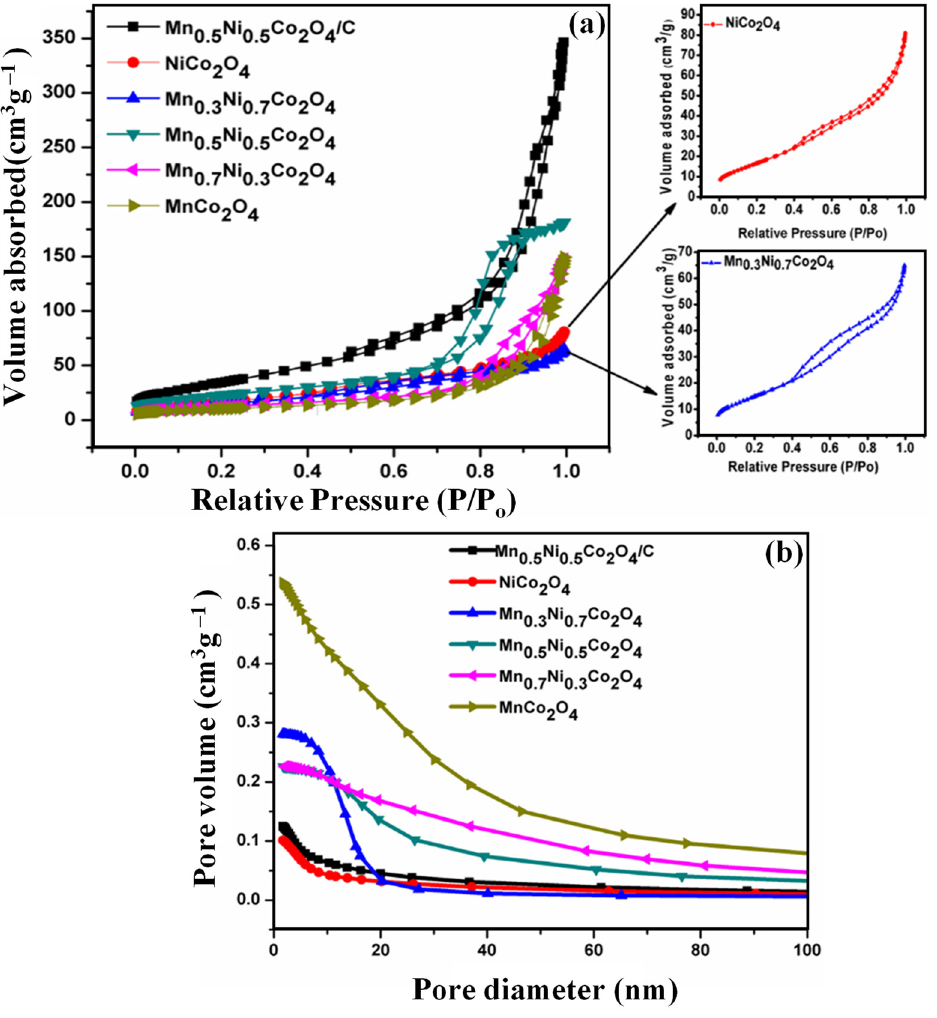
Figure 6. ( a ) Nitrogen adsorption/desorption isotherms and ( b ) pore size distributions of